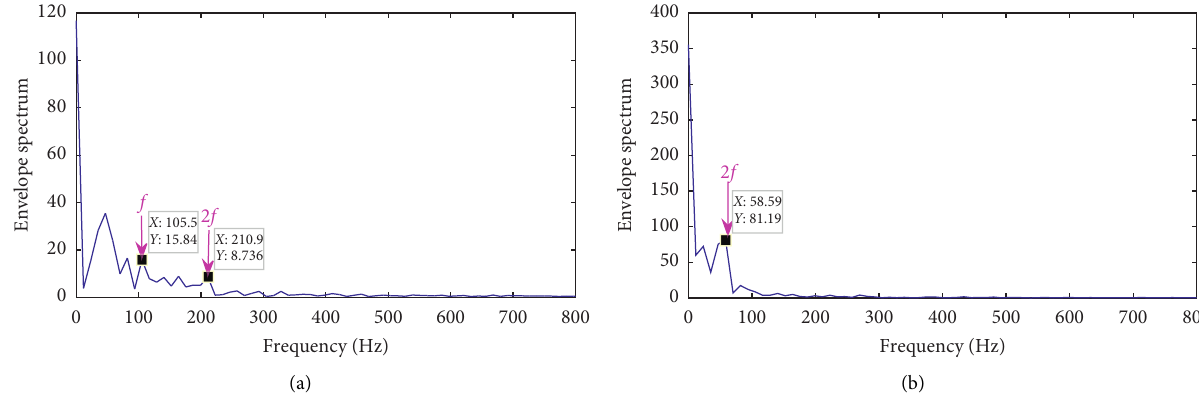
Figure 17: Envelope spectrum of effective mode extracted by (a) the maximum kurtosis and (b) the maximum correlation